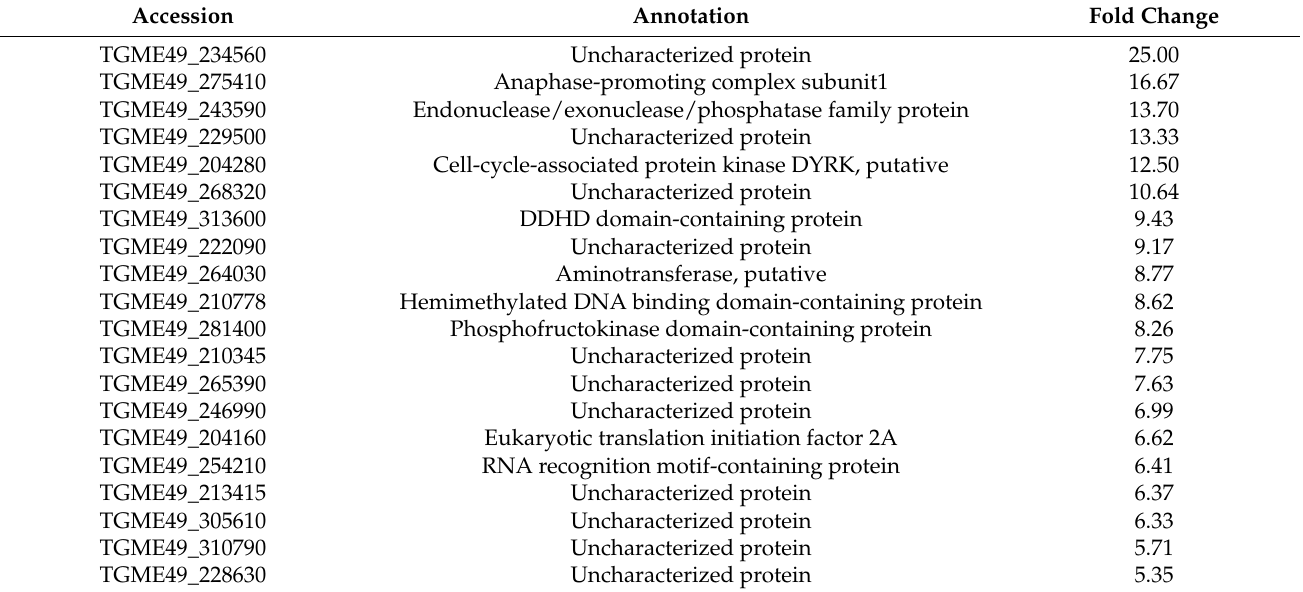
Table 3. Proteins quantified in MOB1 and control pull-downs with fold change above